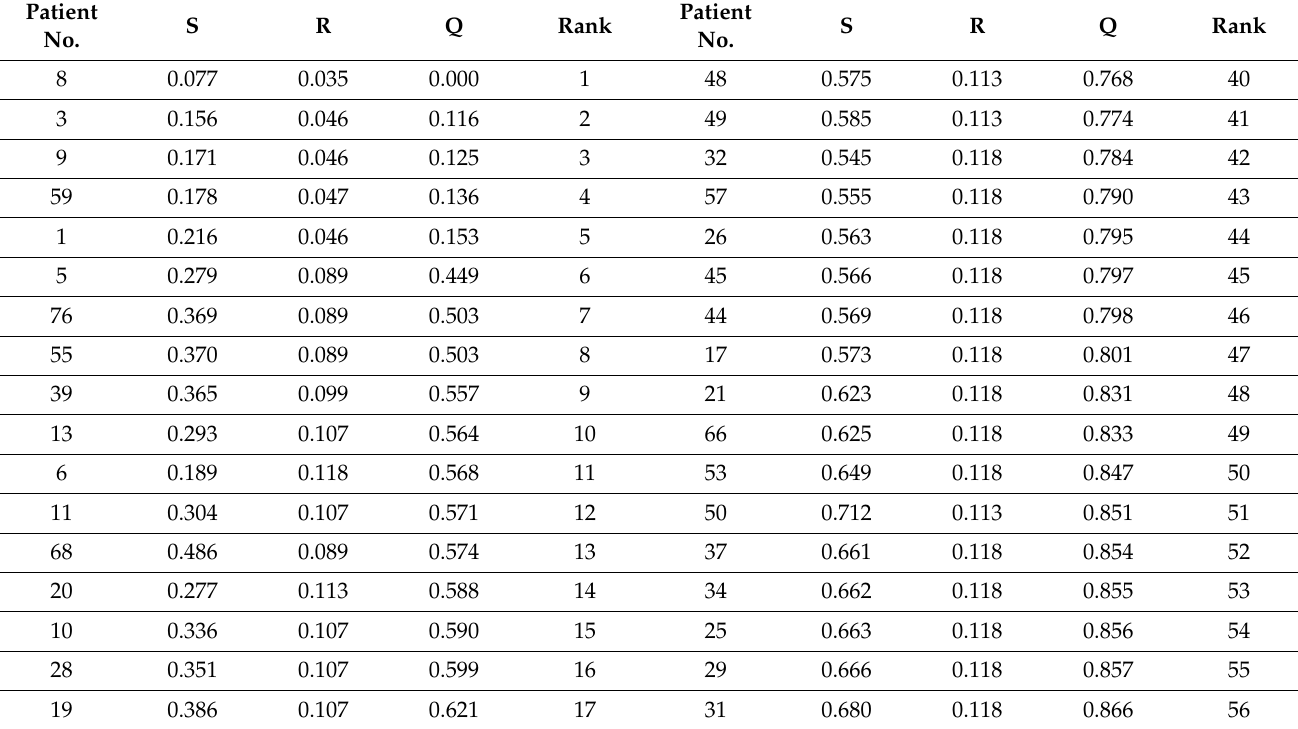
Table 6. Final ranking of COIVID-19